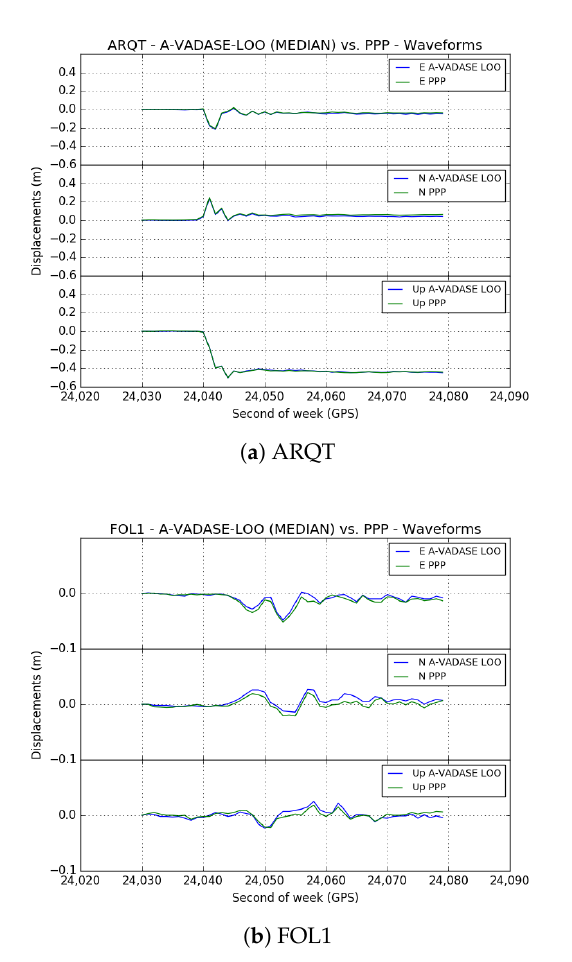
Figure 8. A-VADASE-LOO vs. PPP in the 30-s interval across the 30 October 2016 main shock (GPS time). Table 2. Comparison between A-VADASE-LOO and PPP solutions: 24 August 2016 earthquake.